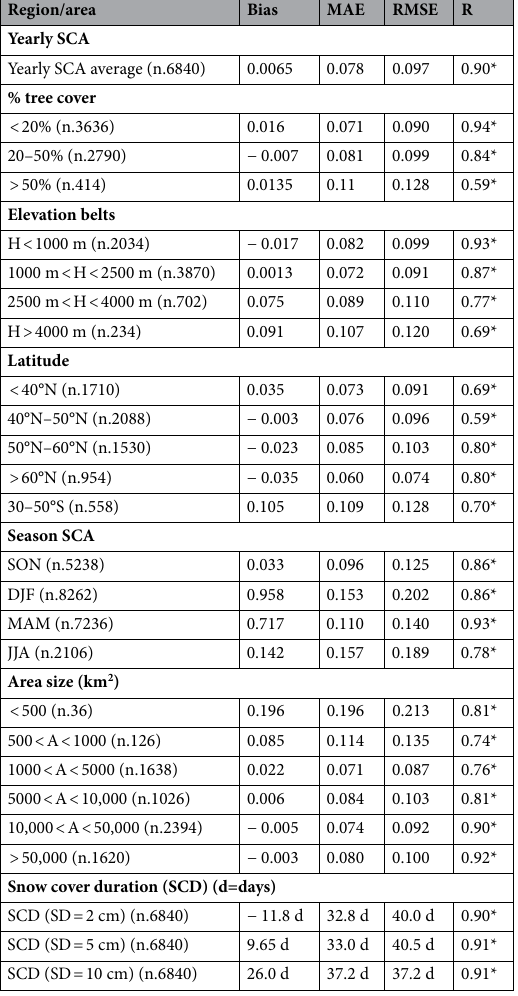
Table 1. Comparison between MODIS SCA and SCD and modeled FLDAS data (*Pearson correlation significant at 5% level). For SCD, different thresholds of Snow Depth (SD) were tested. For each data set, in parenthesis the number of points used in the evaluation is